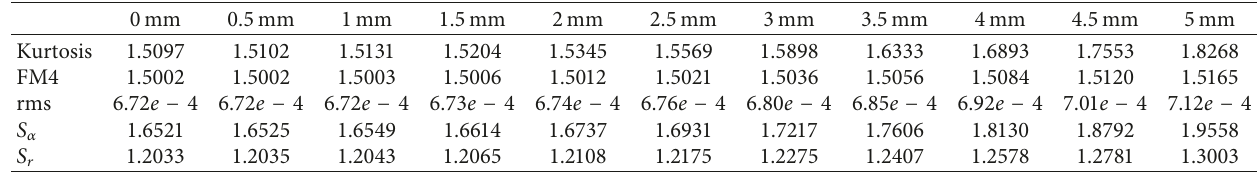
Table 6: Indicators of the vertical acceleration of car body vibration under each damage states.